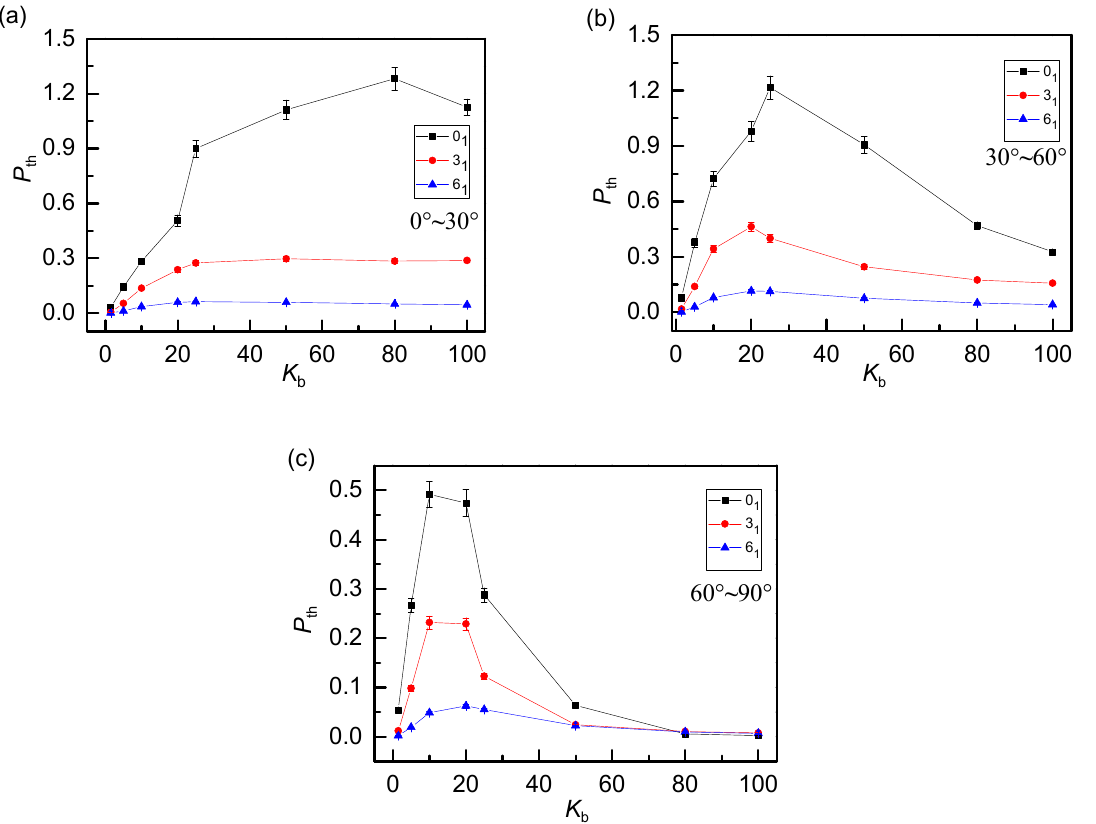
Figure 9. Average threading number P th within angles of 0 °~ 30 ° ( a ), 30 °~ 60 ° ( b ) and 60 ° ~90 ° ( c ) as a function of bending energy K b for three knot types. The anisotropic character and expansion effects are both suppressed by the complex topology.